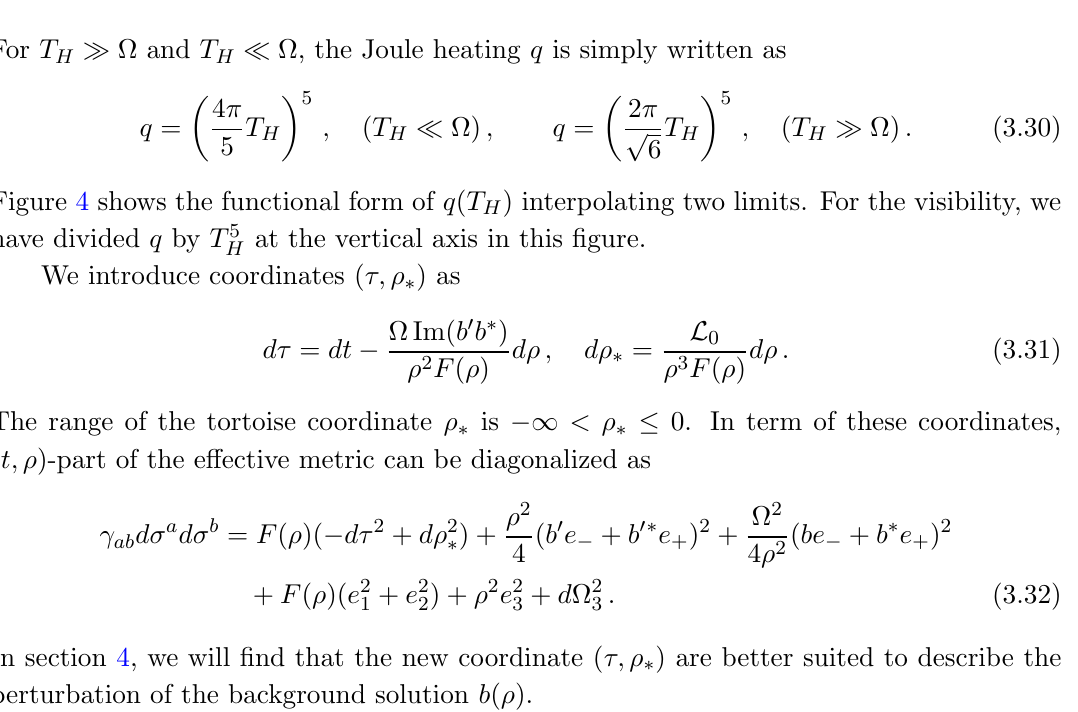
Figure 4. Joule heating q as a function of Hawking temperature T H